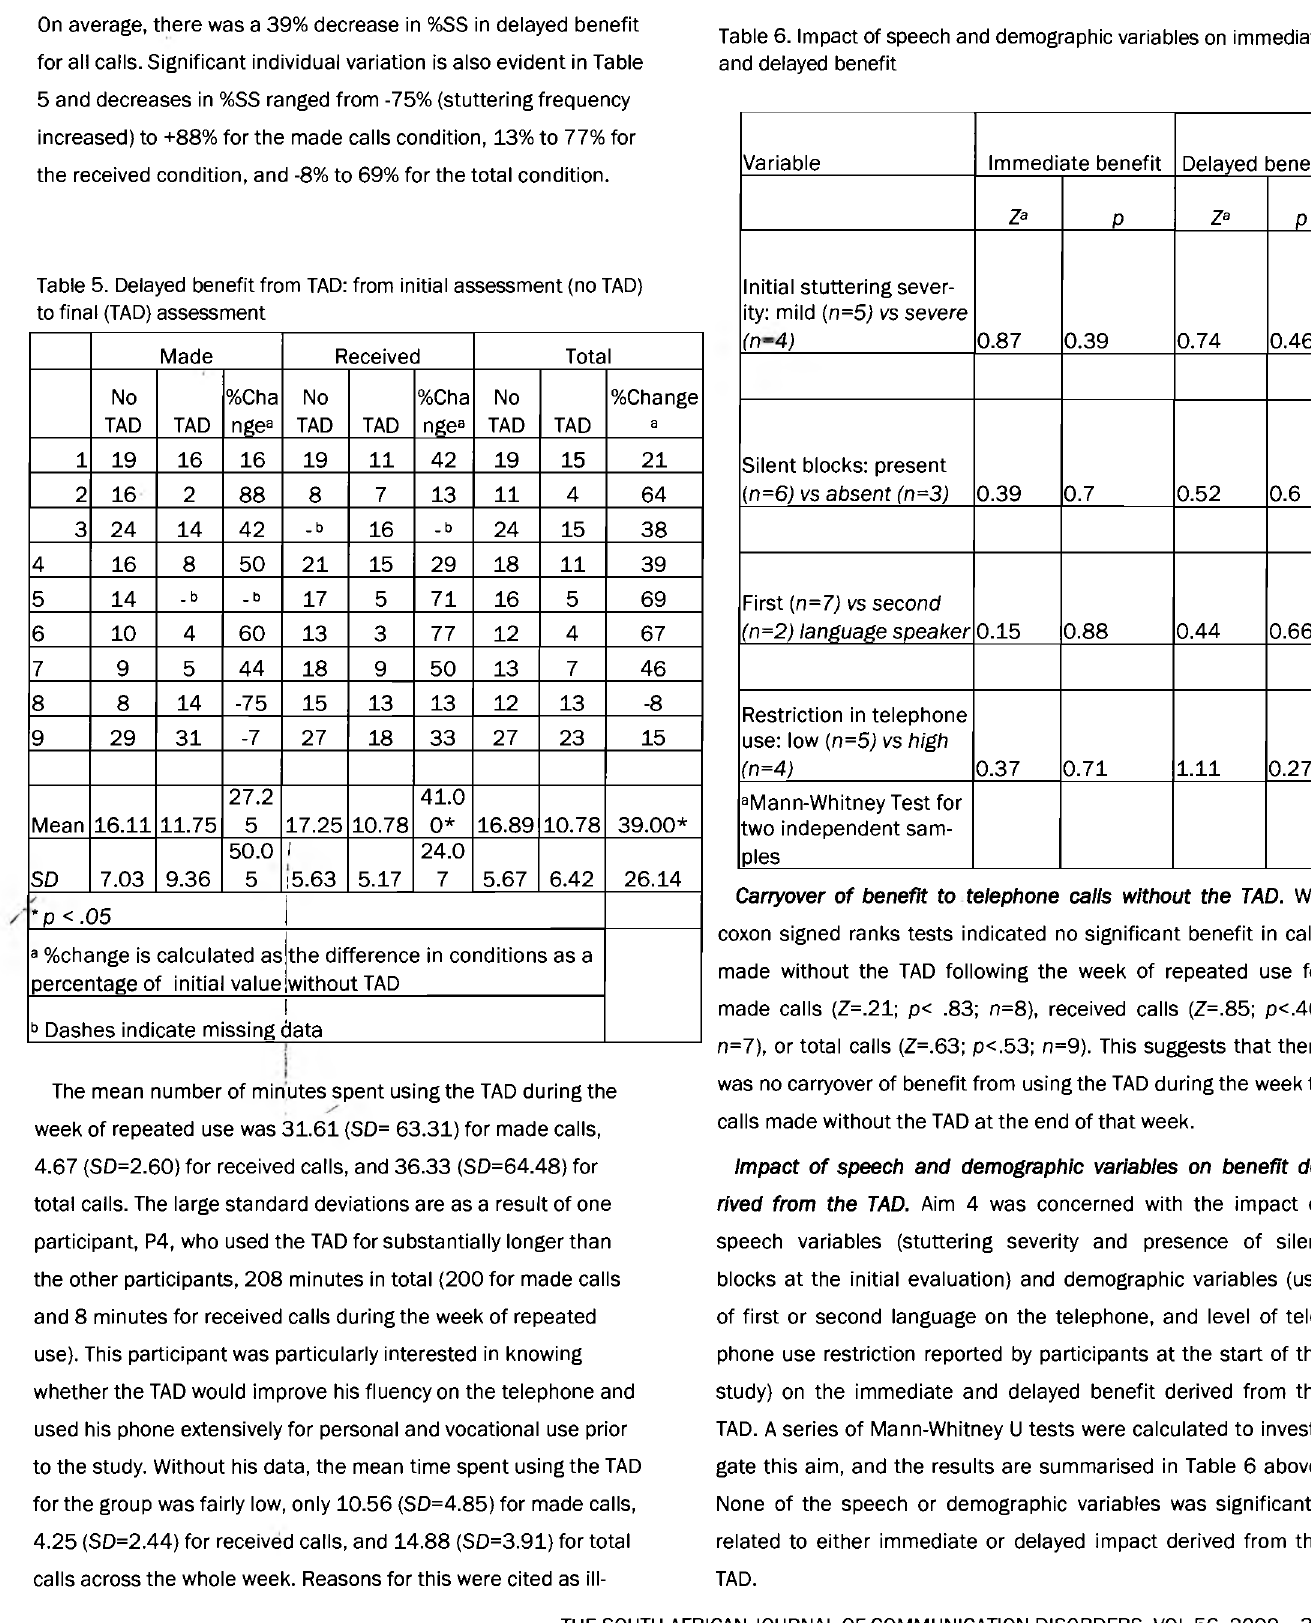
Table 6. Impact of speech and demographic variables on